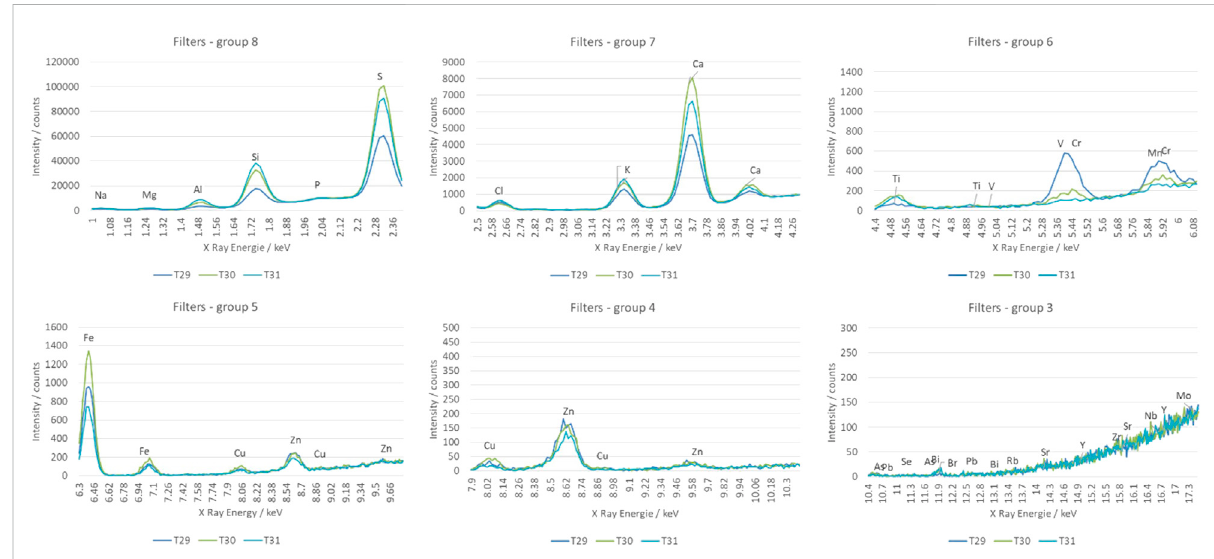
FIGURE 5 Spectrum of elements obtained by EDXRF in selected PM 10 samples (T29, T30, and T31) during measurements in the Pova ž ský Chlmec tunnel.